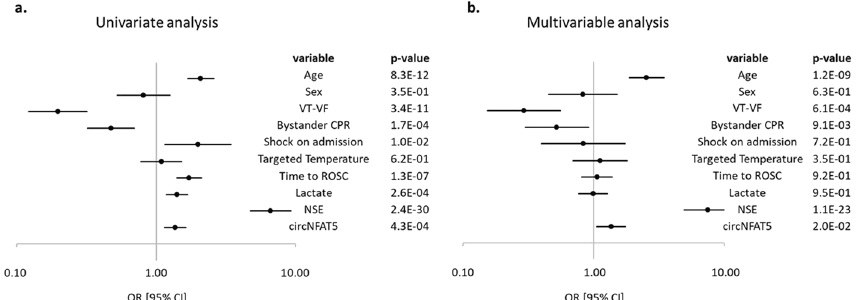
Fig. 3 Logistic regression models to predict 6‑month neurological outcome. Forest plots showing the odds ratio (OR) with 95% confidence interval [95% CI] for the prediction of 6‑month neurological outcome in ± TTM‑trial patients. a Univariate logistic regression analysis. b Multivariable logistic regression analysis